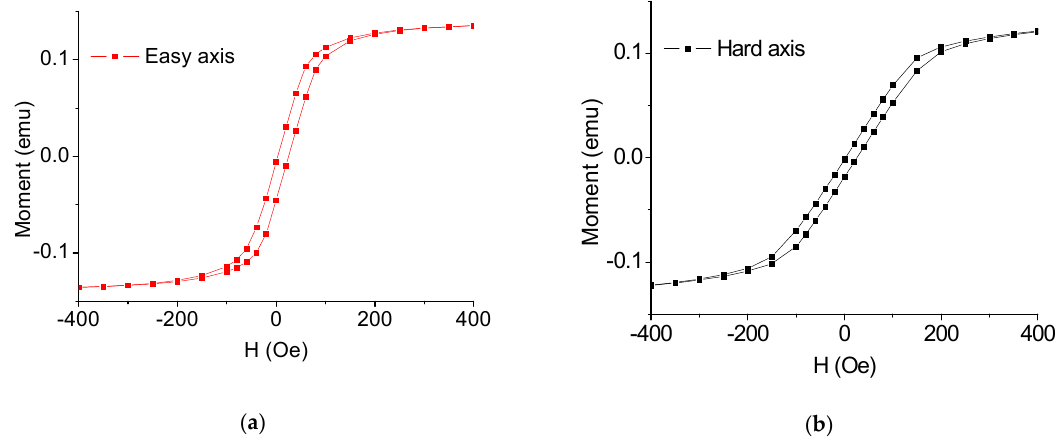
Figure 2. The magnetic hysteresis loop of the amorphous ribbon: ( a ) easy axis ( b ) hard axis.